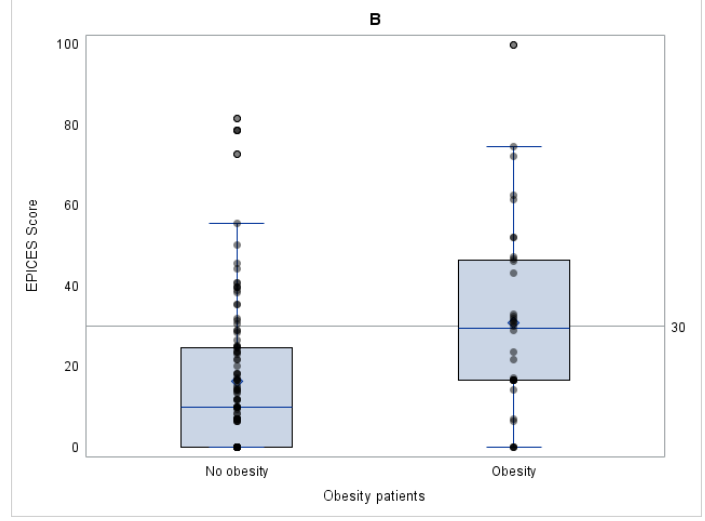
Figure 1. ( A ) Scatter plot and regression line between EPICES score ( X -axis) and BMI Z-score ( Y -axis) in the 147 children with PWS. ( B ) Boxplot of EPICES score in the obese group vs. the non-obese group.